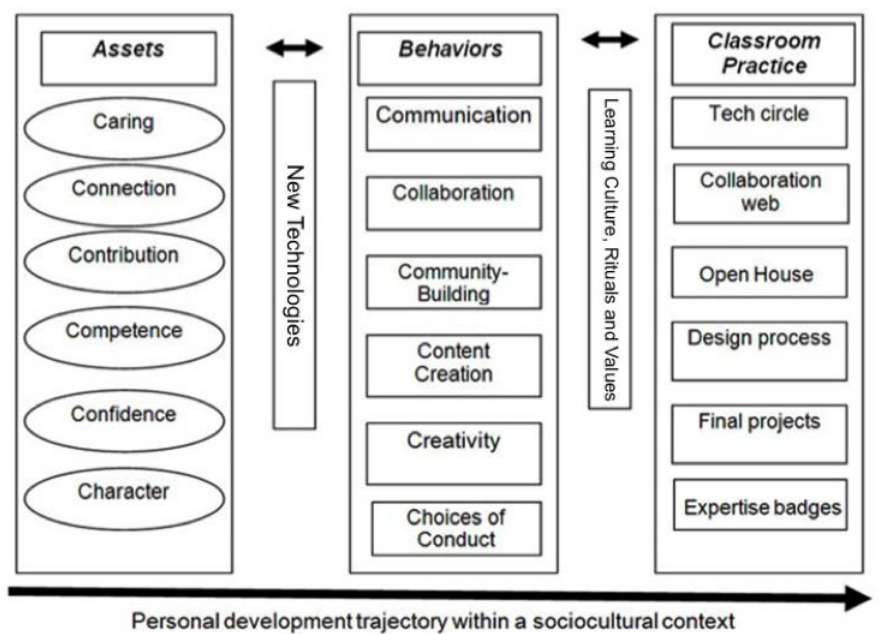
Figure 1. The Positive Technological Development Framework. The PTD behaviors (center column) are rooted in character assets of Positive Youth Development (left) and can be supported by positive classroom practices with technologies (right) (reproduced with author permission from Bers,